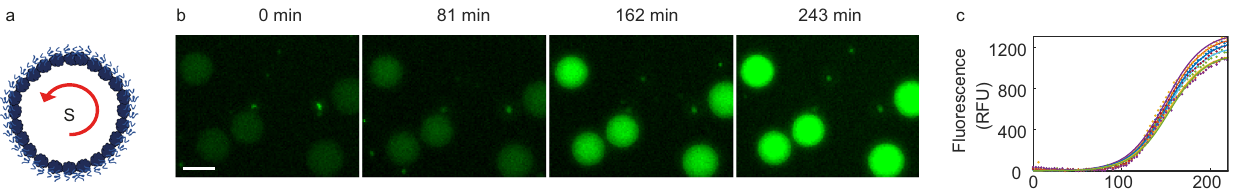
Fig. 3 Proteinosomes contain and support autocatalytic PEN DNA reactions. a Autocatalytic reaction, when S = S ′ the PEN DNA reaction is autocatalytic. b Wide fi eld optical fl uorescence microscopy images show increasing EvaGreen fl uorescence from DNA production within proteinosomes. Final total concentration of DNA template is 0.6 nM, initial concentration of primer/substrate is 1 nM at 42 °C. Images are a representation from a single experiment. Scale bar is 20 μ m. c Autocatalytic growth curves obtained from image analysis show fl uorescence increase from six individual proteinosomes. Source data are available in the source data fi stranded DNA in a non-sequence-speci fi c manner (Supplemen- tary Fig. 7). In this experiment, this happens when the substrate strand is extended by the polymerase, or when the substrate or product strand binds to the template strand. Using custom- written FIJI analysis (Supplementary Fig. 8), the fl uorescence intensity as a function of time was obtained from individual proteinosomes, showing characteristic autocatalytic pro fi les (Fig. 3c).